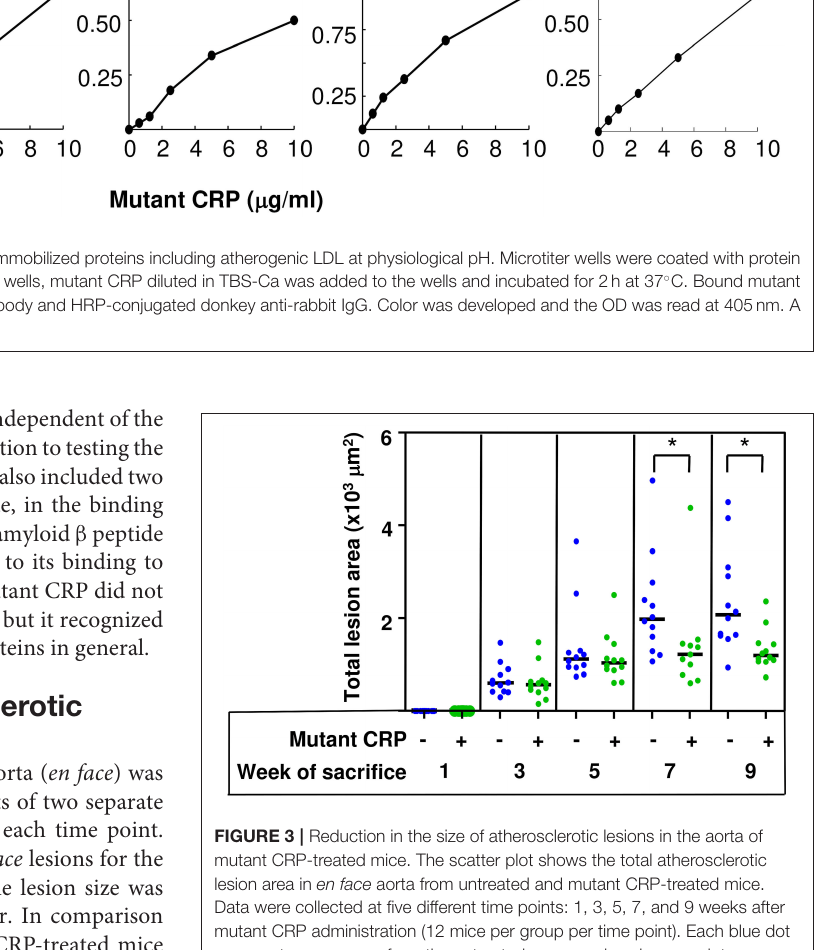
point between untreated and mutant CRP-treated groups of mice. Similar results were seen when the data from each of the two experiments (6 mice/group/time point/experiment) were analyzed separately ( Supplemental Figure 2